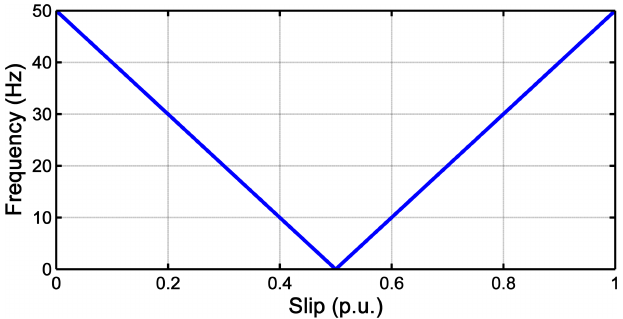
Figure 3. Time evolution of the left sideband harmonic (LSH) ( top ), of the motor speed ( middle ) and of the motor slip ( bottom ) during the start-up transient of the simulated induction machine (IM) given in Appendix A. The vertical line corresponds to the time when the slip s = 0.5 is reached.